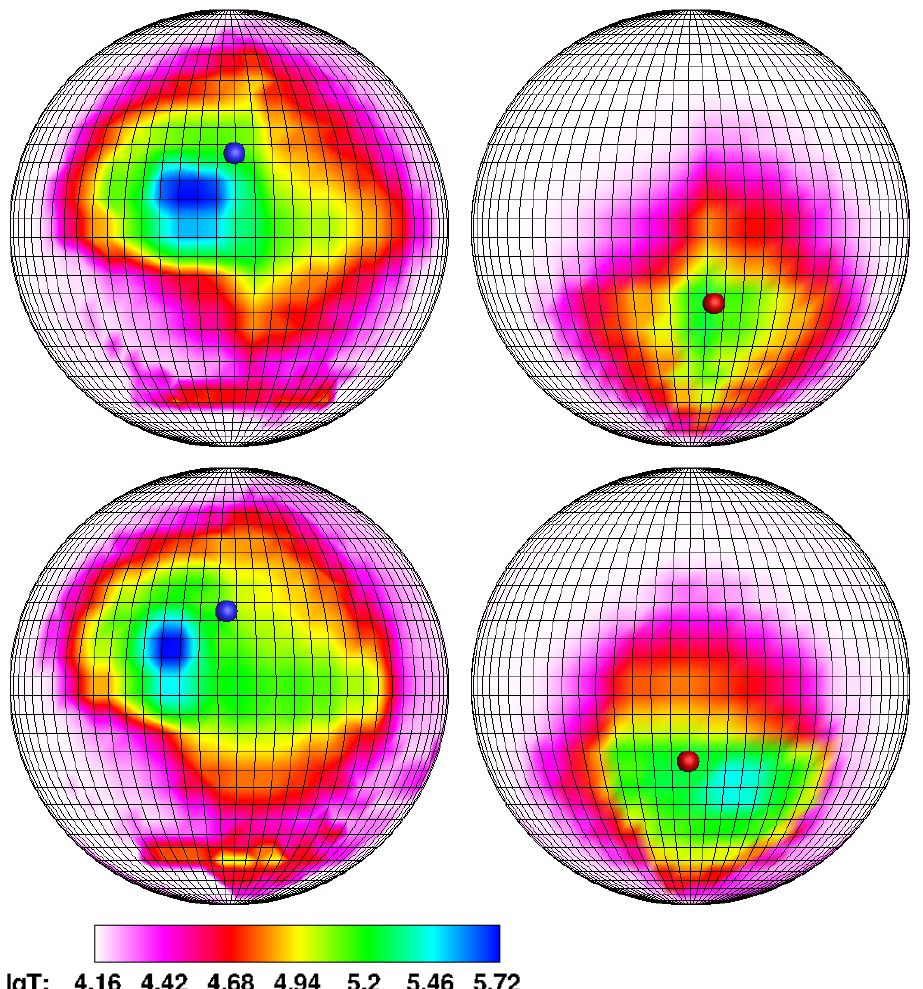
Figure 20. Temperature distribution over the accretor surface for the asynchronous polar with an offset dipole when switching the flow from the north magnetic pole to the south one. The temperature maps for Phase 1 ( upper panel) and for Phase 2 ( lower panel) are